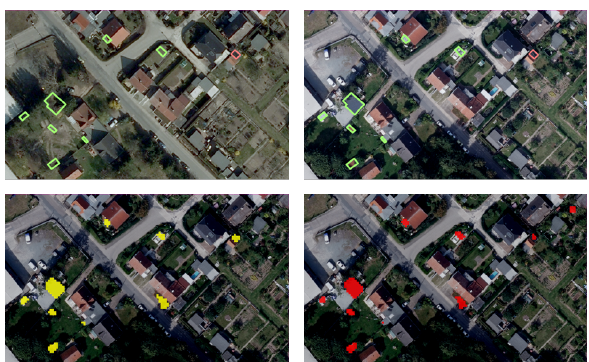
Figure 1. Change detection results using the HC + C building input at τ = 0 . 5 . Top row: Orthophotos from 2010 (left) and 2016 (right) with the reference classes new in green and demolished in red. Bottom row: binary change detection results for ALS-ALS (left) and ALS-DIM point clouds